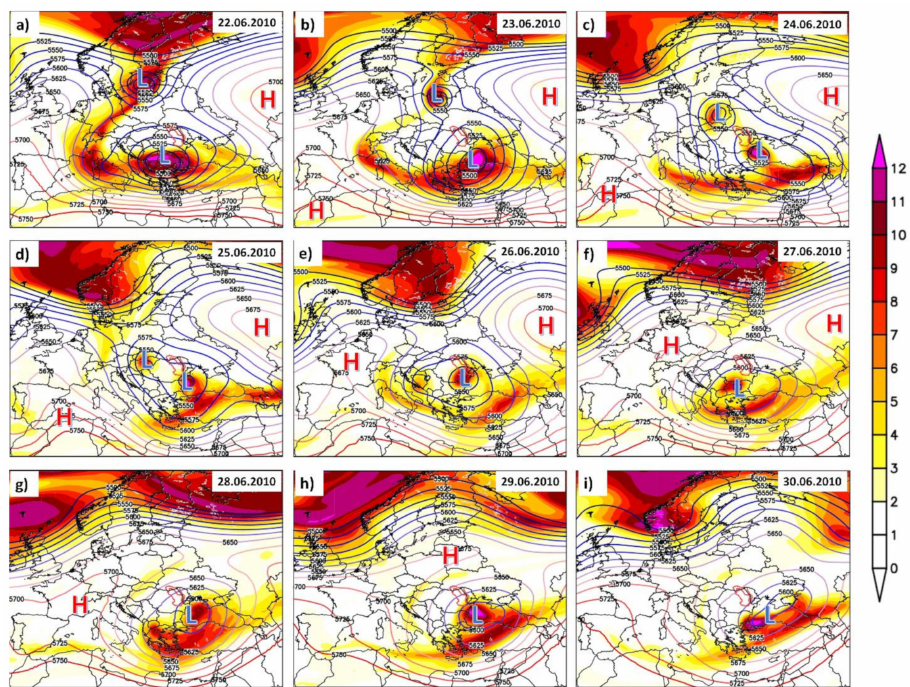
Figure 9. Daily potential vorticity (PV) at 330 K (shaded colors) and daily geopotential height at 500 hPa (Z500) (contour lines) for: ( a ) 22 June 2010; ( b ) 23 June 2010; ( c ) 24 June 2010; ( d ) 25 June 2010; ( e ) 26 June 2010; ( f ) 27 June 2010; ( g ) 28 June 2010; ( h ) 29 June 2010; and ( i ) 30 June 2010. Units: PV (PVU) and Z500 (m). L (blue) denotes low-pressure systems and H (red) denotes high-pressure